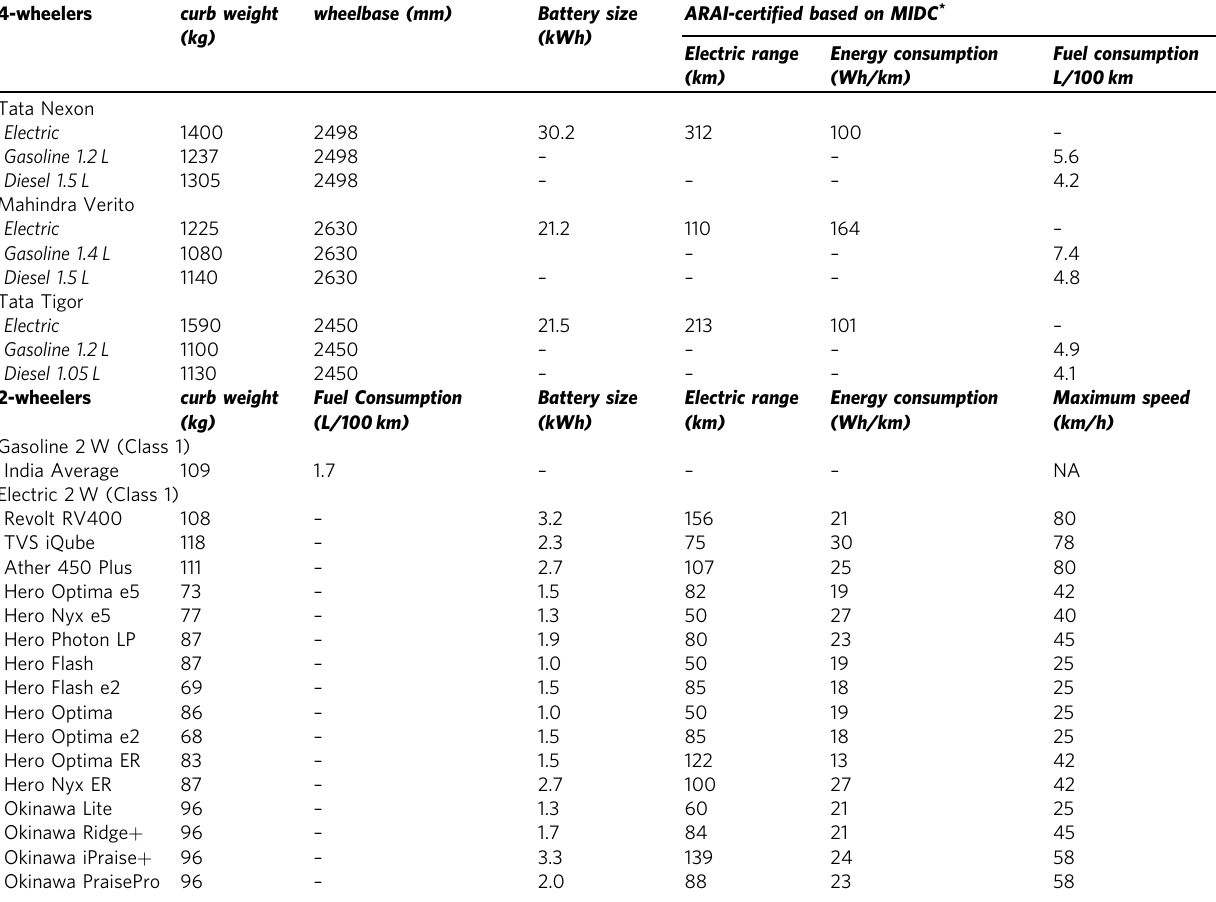
Table 1 Summary of key vehicle characteristics for the 2-wheelers and 4-wheelers.